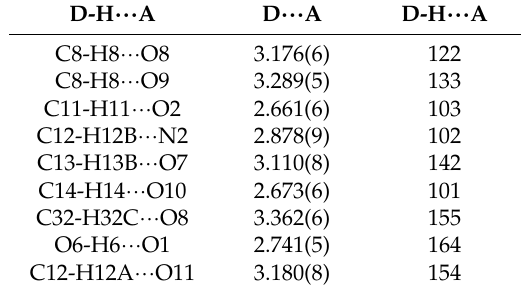
Table 9. Hydrogen bondings (Å, °) for complex 3 .